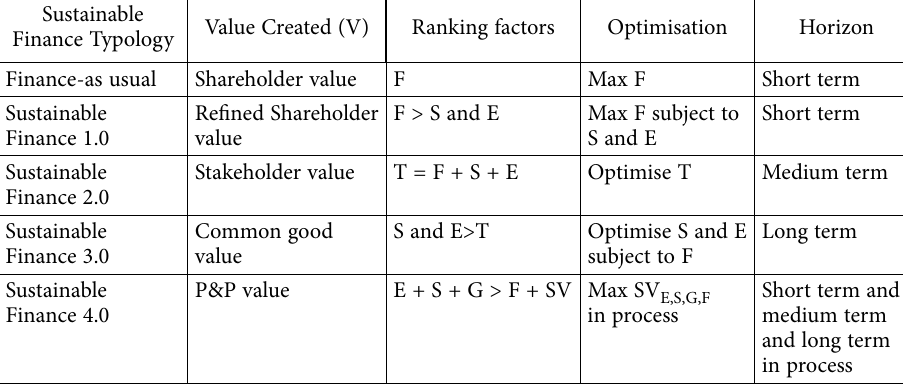
Table 5. Framework for Sustainable Finance and people and planet value (source: own elaboration based on Schoenmaker, 2017) Sustainable Value Created (V) Ranking factors Optimisation Horizon Finance Typology Finance-as usual Shareholder value F Max F Short term Sustainable Refined Shareholder F > S and E Max F subject to Short term Finance 1.0 value S and E Sustainable Stakeholder value T = F + S + E Optimise T Medium term Finance 2.0 Sustainable Finance